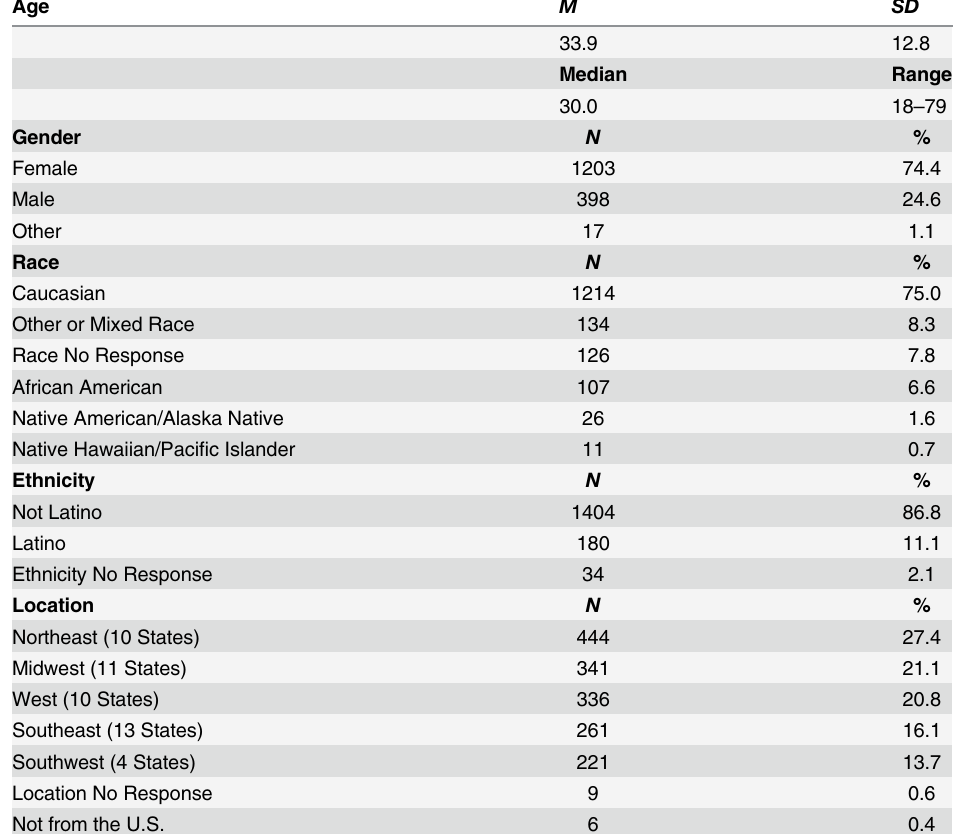
Table 1. Demographic